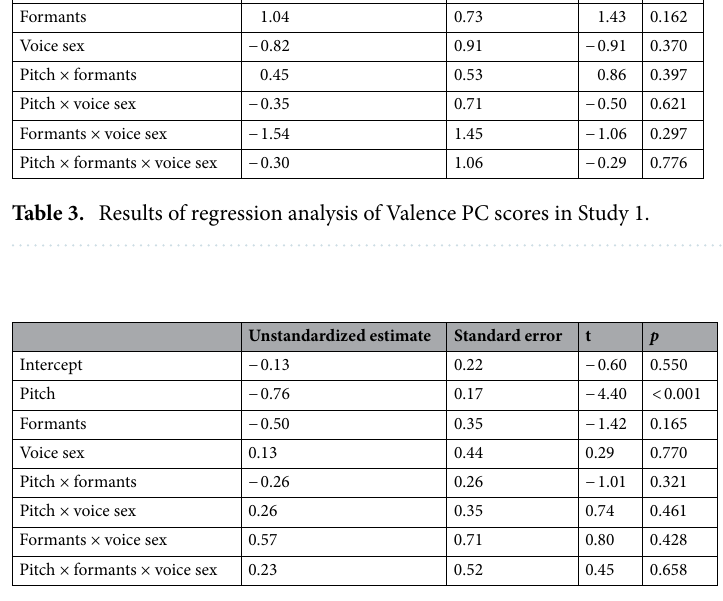
Table 4. Results of regression analysis of Dominance PC scores in Study